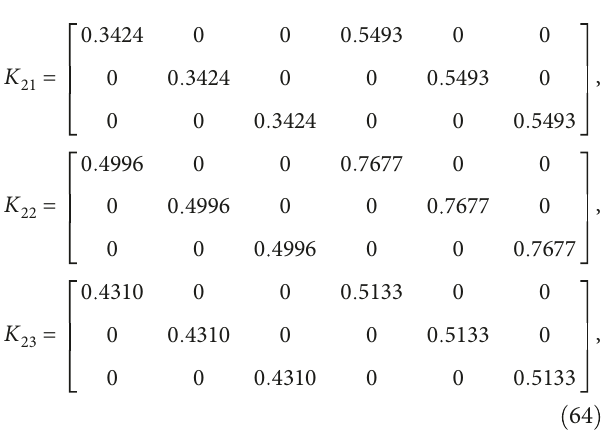
Figure 3: State trajectories of the open-loop FTBF trajectory.